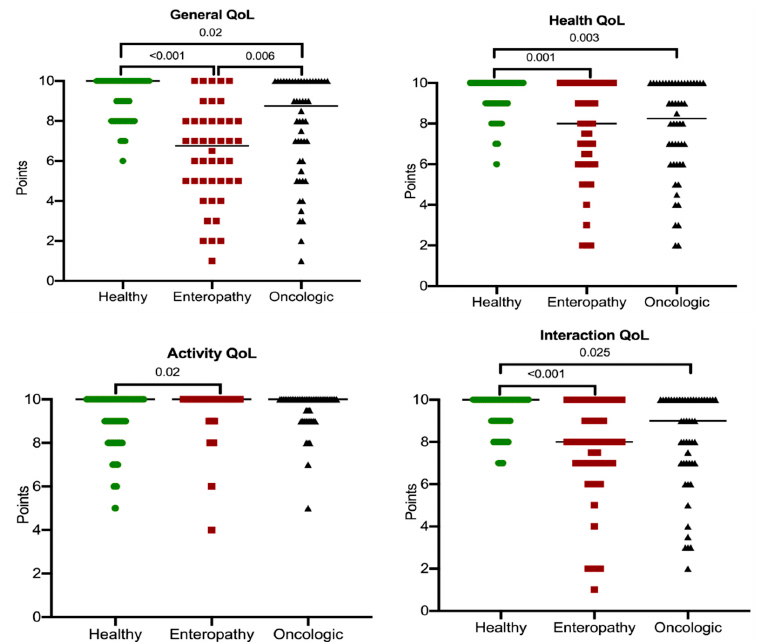
Figure 2. Statistically significant QoL scores (general, health, activity, and interaction) for healthy, enteropathic, and oncologic dogs. In the enteropathic group, the severity of the disease was assessed on the first visit and at the subsequent follow-up using the CCECAI clinical score. The median CCECAI on the first visit was 4.5 and, on the control visit, it was 1. The CCECAI values on the follow-up were statistically lower than those determined on the first visit ( p < 0.001), and a clinical response was achieved in 75% of the cases. Regarding the QoL of enteropathic dogs, the scores of three out of five items were significantly higher on the follow-up compared to the first visit (Table 1). Table 1. Comparison of QoL scores on first visit and follow-up in enteropathic dogs (* = p < 0.05). First Visit 0.585 The severity of the enteropathy, as evaluated by CCECAI values obtained on the first visit, was negatively associated with QoL: dogs with a clinically insignificant–mild illness dogs had a statistically higher QoL than moderate-to-very severely ill dogs, for all the five investigated features (Table 2).